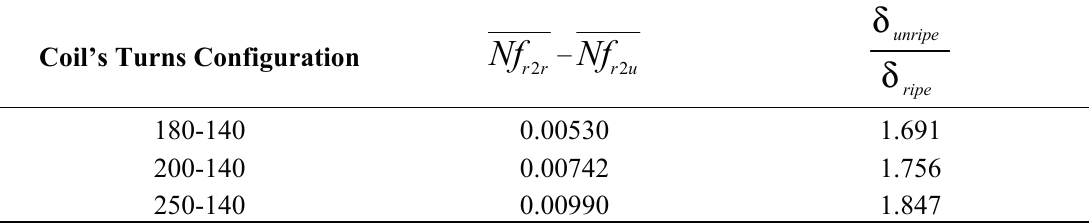
Nf Nf and and ratio between δ unripe and δ ripe for the rr 2 ur 2